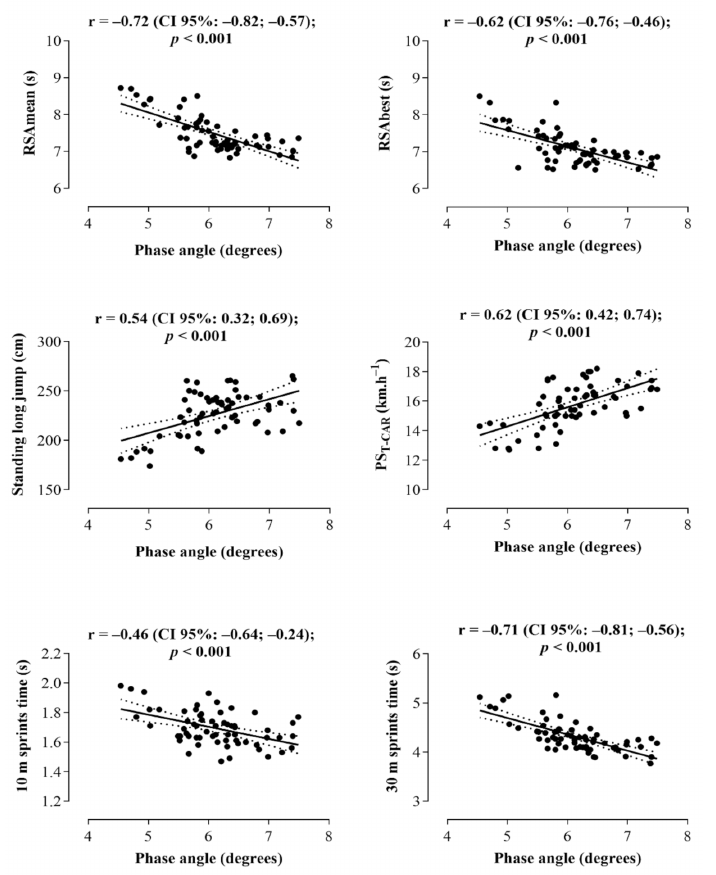
Figure 1. Correlation between the phase angle and physical performance outcomes for total sample ( n =